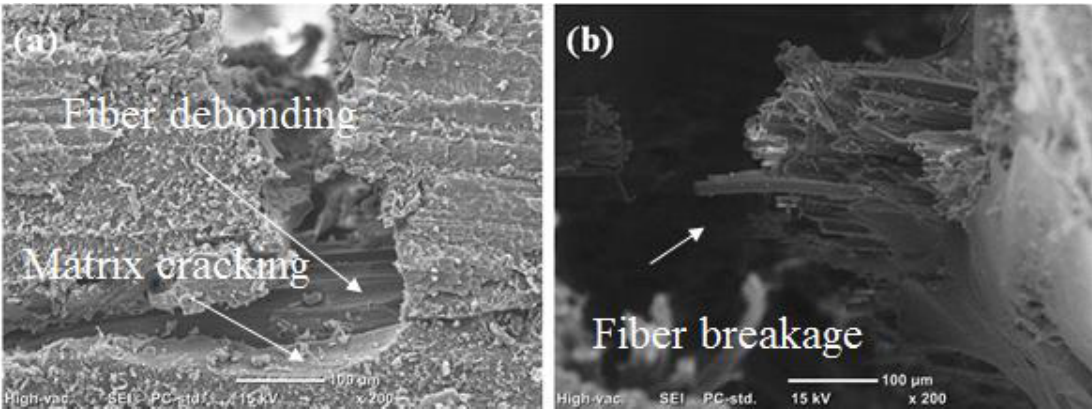
Figure 9. Comparison of SEM micrographs of: ( a ) NF WJF30 and ( b ) SH WJF30.